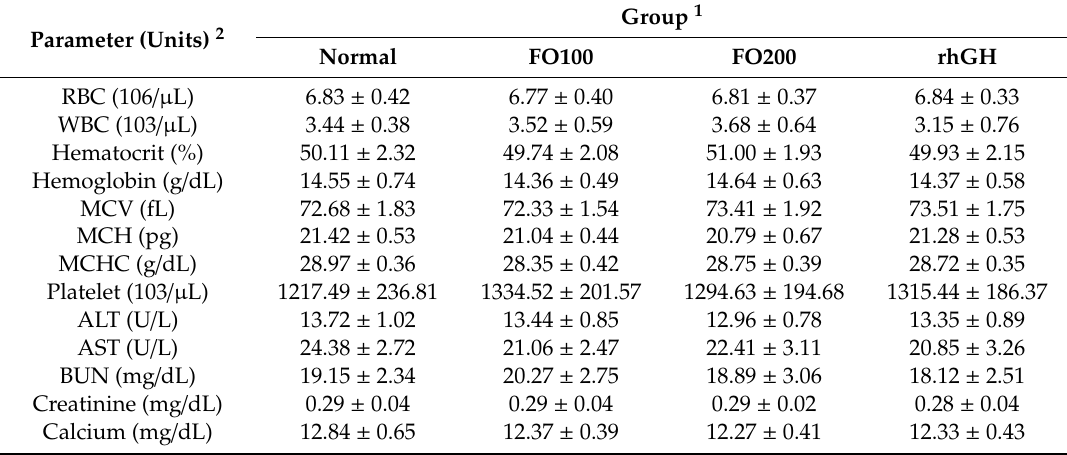
Table 1. Hematological and biochemical analysis of the Sprague-Dawley rats 14 days after treatment. Parameter (Units) 2